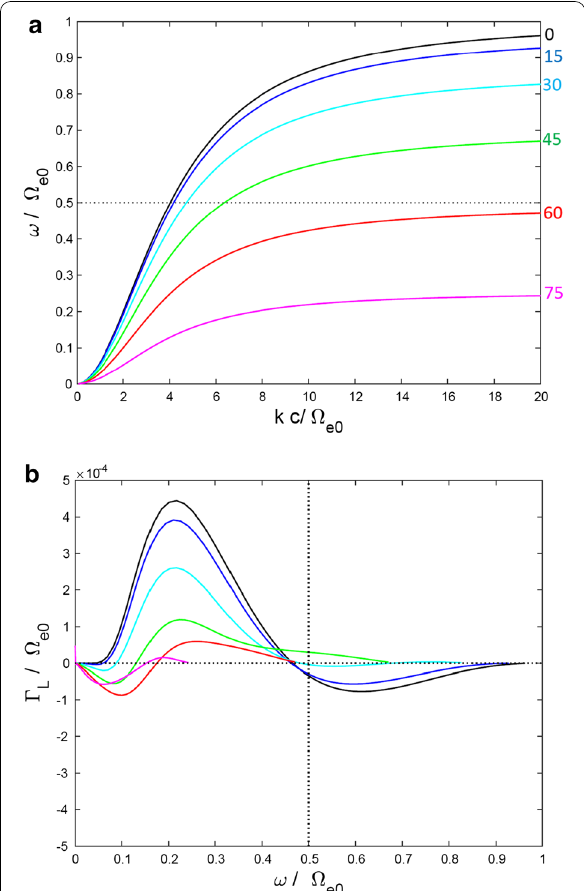
Fig. 4 Linear dispersion relation. Linear dispersion relation of a plasma consisting of cold electrons, cold ions, and minor hot 2 10 − 3 ). A subtracted Maxwellian for the electrons ( n h / n c = × 0.25 c , 1.0 , U t 0.3 , ρ energetic electrons is assumed with β = = � = 3.0 c . The frequencies and linear growth rates for different and U t ⊥ = wave normal directions θ 0, 15, 30, 45, 60, 75 degrees are shown in = the same colors, respectively